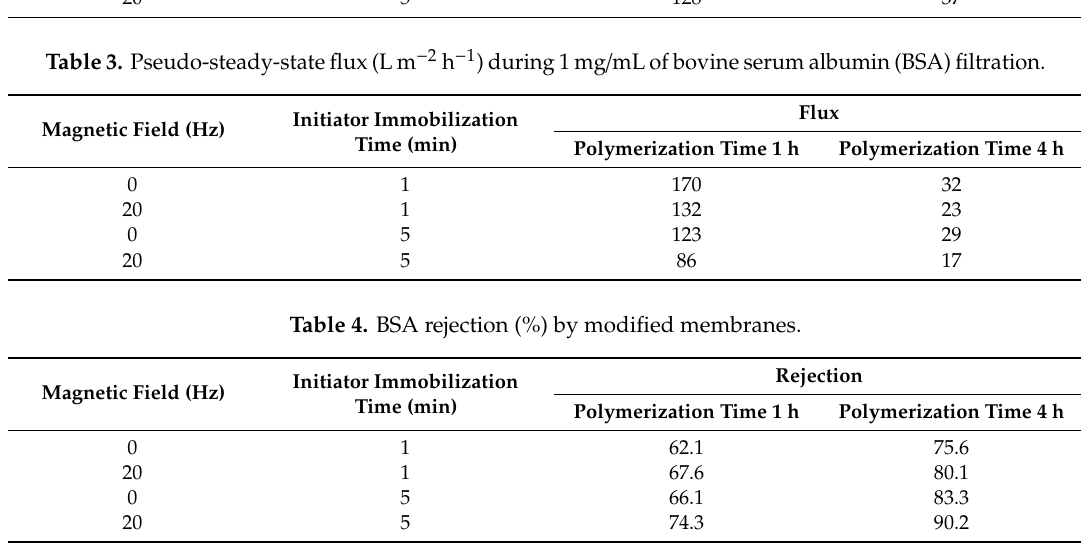
Table 5. Pseudo-steady-state flux (L m − 2 h − 1 ) during 1 mg / mL of dextran (70 kDa) filtration. Magnetic Field